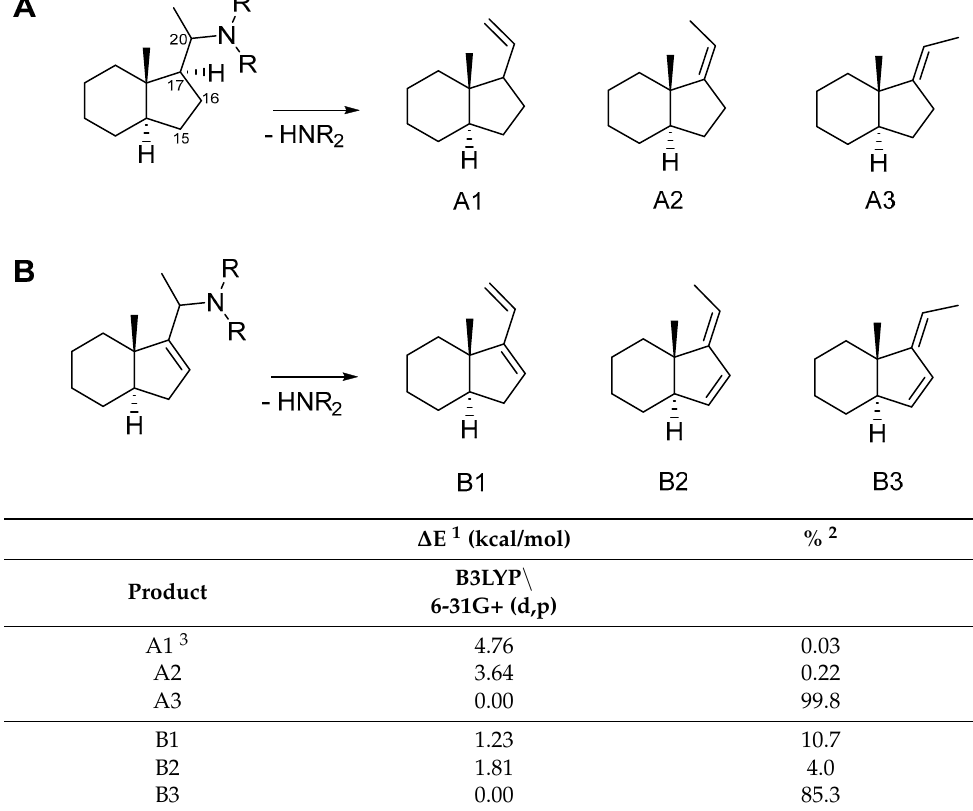
Table 3. Results of quantum mechanical energy calculations (density functional theory (DFT) at the B3LYP\6-31G+(d,p) level) for the possible fragments arising from loss of the C-20 substituents. A: Saturated ring D; B: Ring D with double bond between C-15 and C-16. Calculations were carried out with the perhydro indane model compounds as depicted.